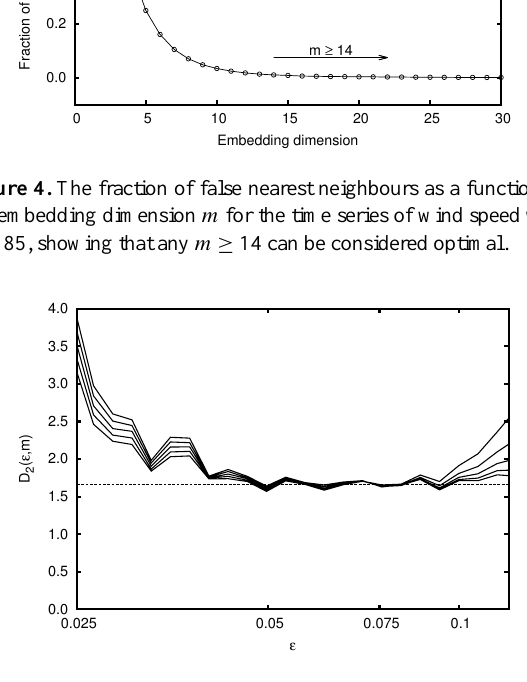
Fig. 7. The power spectrum of wind speed time series as a function of frequency at location Latitude: 34.98420 Longitude: -104.03971. Broadband and exponential decay of the power with frequency are 0 . 008 . ± typical characteristics of chaotic signals.